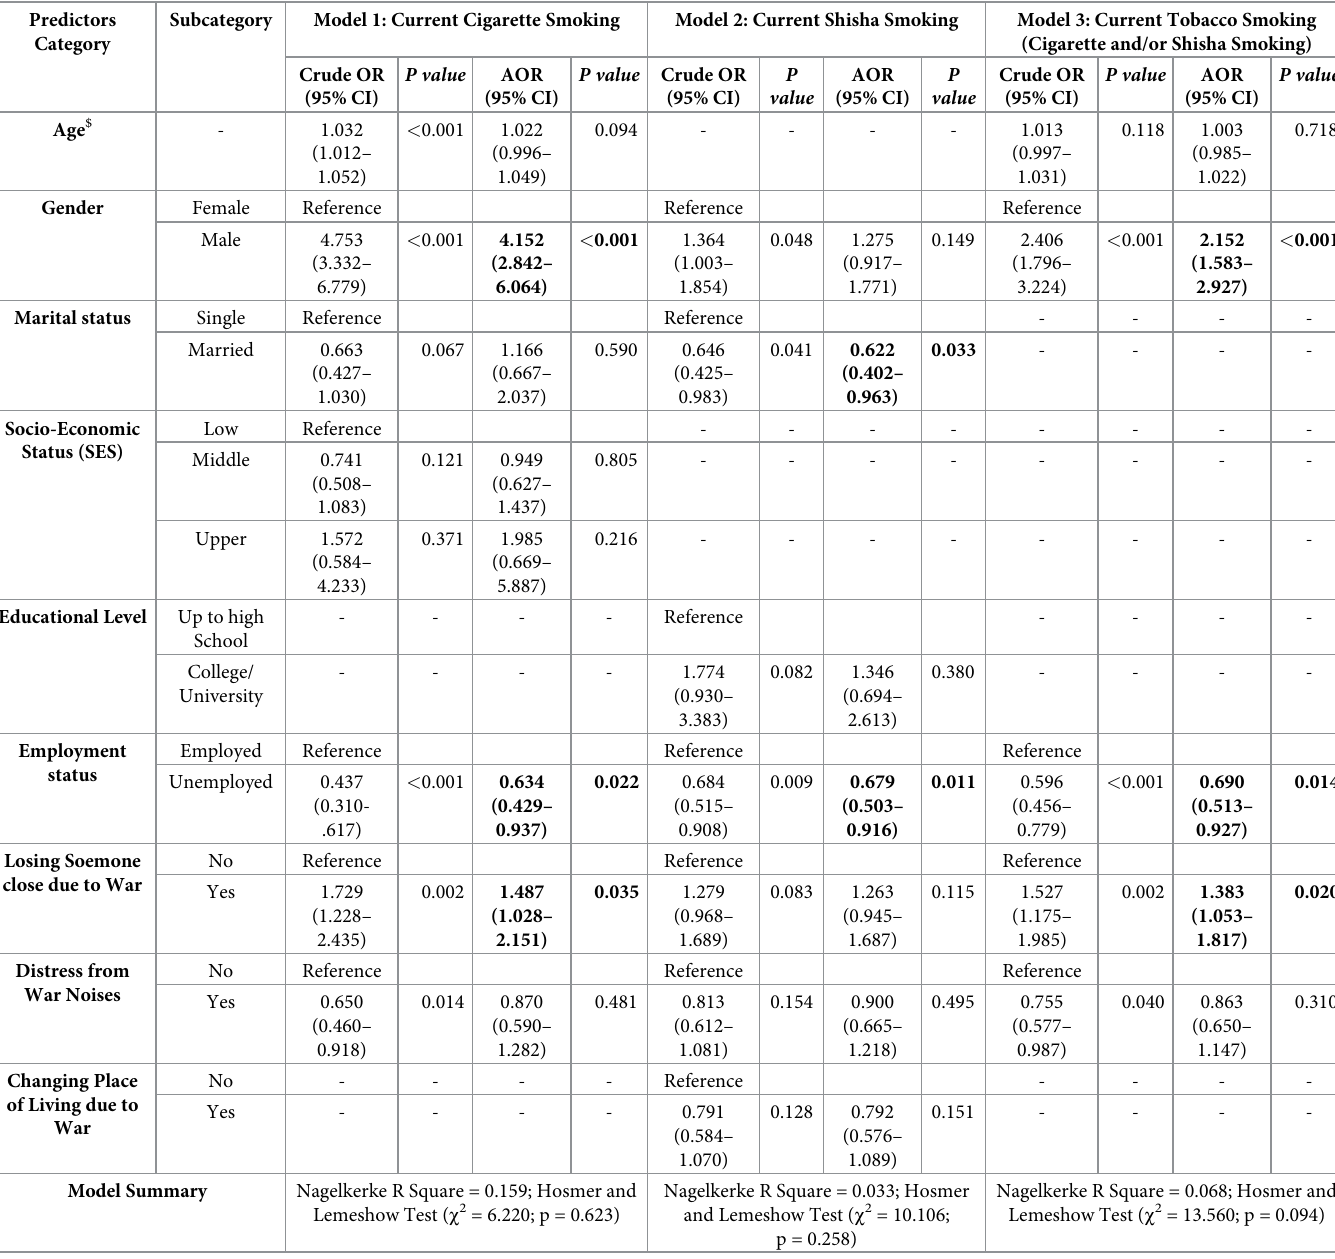
Table 4. Multivariable logistic regression analysis for the association between type of tobacco smoking and various predictors ┼ . Predictors